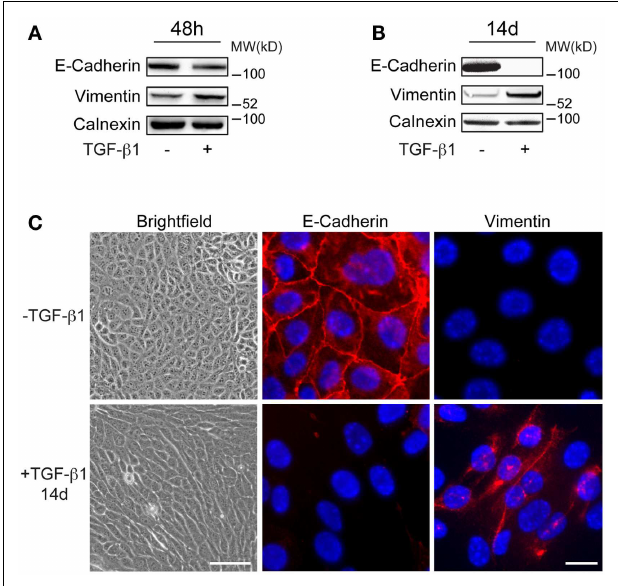
FIGURE 1 | Characteristics of long-term EMT cells . (A,B) Western blot analysis showing more prominent changes in E-cadherin and vimentin expression in EpRas tumor cells after 14days (B) compared to 48h (A) of TGF- β 1 exposure. Calnexin was used as a internal loading control. (C) Brightfield and immunofluorescence images showing that EpRas cells exposed toTGF- β 1 for 14days acquire characteristic features of EMT including an elongated, fibroblast-like morphology (left panels), loss of E-cadherin at cell–cell junctions (middle panels), and cytoplasmic staining of vimentin (right panels). Scale bars: 20 µ m (left panels); 5 µ m (middle and right